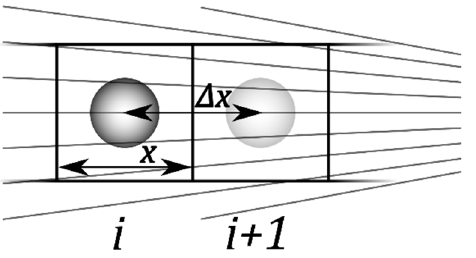
Figure 1. Diagram illustrating the consecutive positions of a spherical object during DEP movement in the inhomogeneous field of a 2D or 3D radial setup. The squares i and i + 1 represent cuboid boxes with x by x geometry ( y = x ) in the sheet plane. The field gradient points in the radial direction. Without any limitation in generality for 3D models of microscopic systems, perpendicular to the sheet plane, a depth of z = x or of z = 1 m can be assumed, as is common in 2D models. The distance of travel between the box centers is ∆ x = x